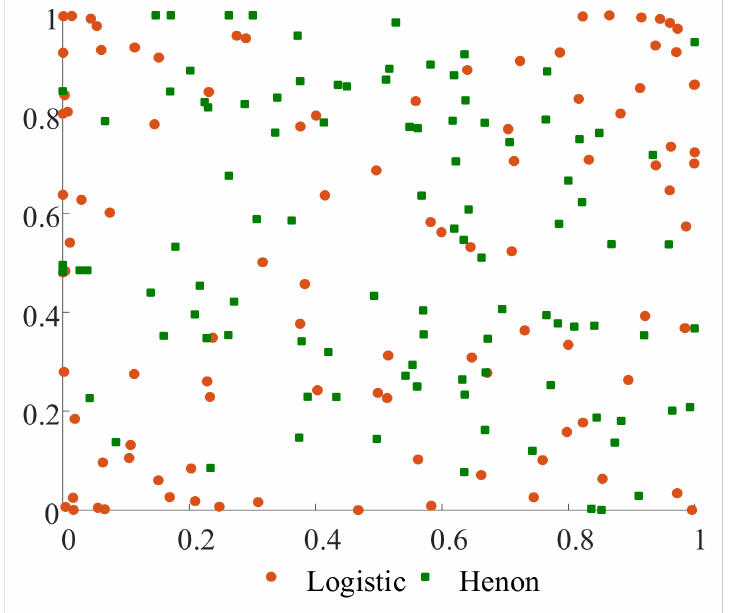
Figure 3. Initialization comparison